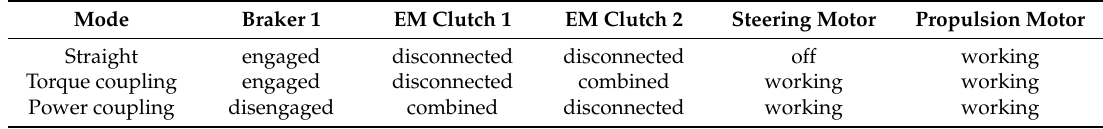
Table 5. Coupling mode and the operation of each component.